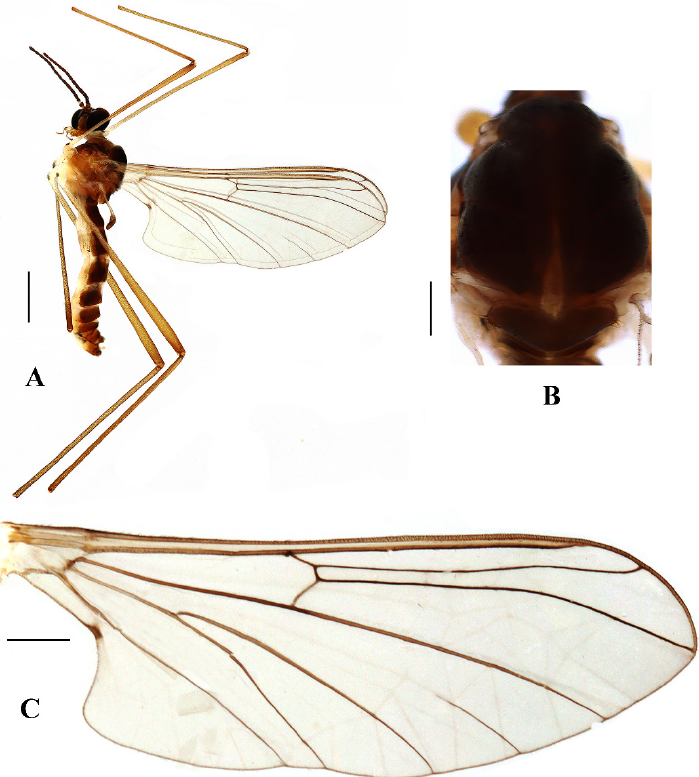
Figure 5. Blepharicera dushanzica sp. nov. (male holotype). ( A ) habitus of male, lateral view ( B ) thorax, dorsal view ( C ) wing. Scale bars: 1.0 mm ( A ), 0.25 mm ( B ), 0.5 mm ( C